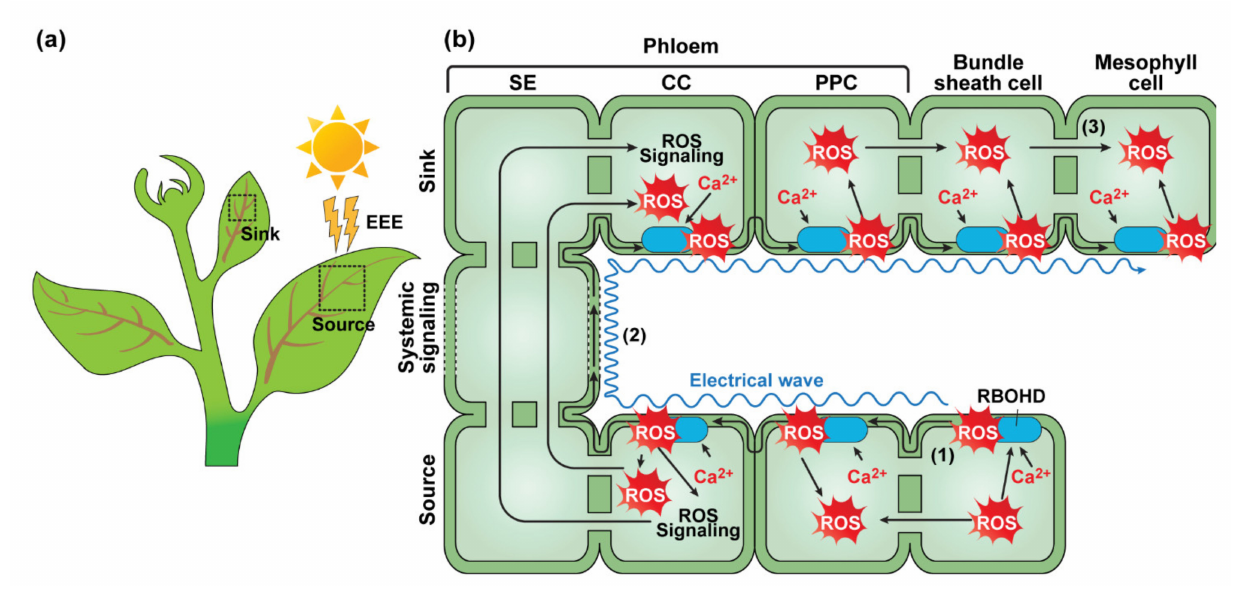
Figure 1. Systemic acquired acclimation (SAA) occurs through a signal network within the plant vasculature. ( a ) Schematic representation of an exposed leaf that receives excess excitation energy (EEE), and a systemic leaf, located at a sink region. ( b ) Proposed signal transduction pathways in SAA. (1) Initial burst of cellular ROS triggers the cascade of cell-to-cell ROS waves, i.e., hydrogen dioxide (H 2 O 2 ) is produced by Respiratory Burst Oxidase Homolog D (RBOHD) (indicated by blue ovals) on the bundle sheath cell plasma membrane. (2) RBOHD relays and maintains an auto-propagating ROS wave along with the plant vascular bundle. Signal amplification propagates rapidly in the companion cell (CC)—sieve element (SE) complexes within the phloem, which may involve calcium ions (Ca 2+ ) and electrical signals. (3) In distal unexposed leaves (systemic leaf), the auto-propagated ROS wave and phloem-transmitted signals are perceived by mesophyll cells, thereby a local defense system is triggered, and the cells within young leaf tissues are acclimated in preparation for the approaching strong EEE treatment to protect their photosynthetic efficiency. PPC, phloem parenchyma